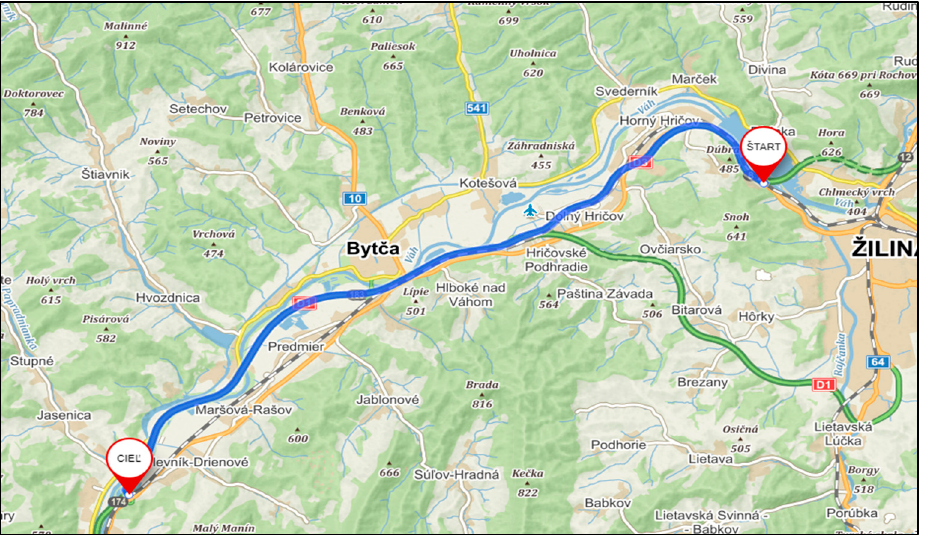
Figure 2. Description of the measuring route—driving on the motorway section (online maps: Mapy.cz).